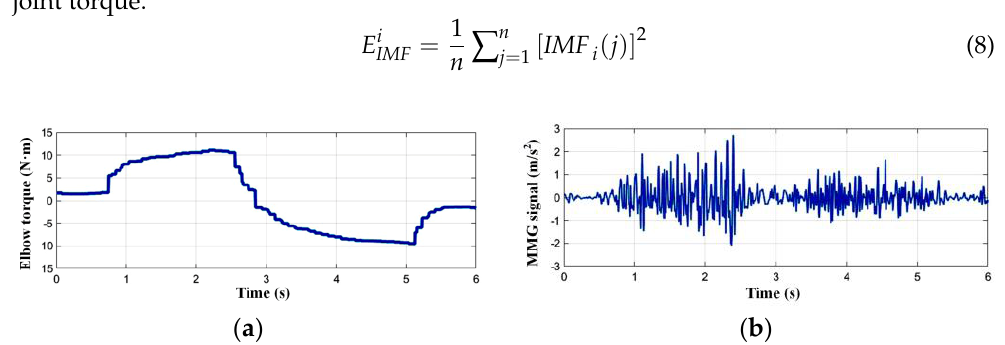
Figure 4. Comparison between the filtered MMG of the brachioradialis muscle and the corresponding elbow joint torque: ( a ) the change curve of joint torque; ( b ) the change curve of filtered MMG.